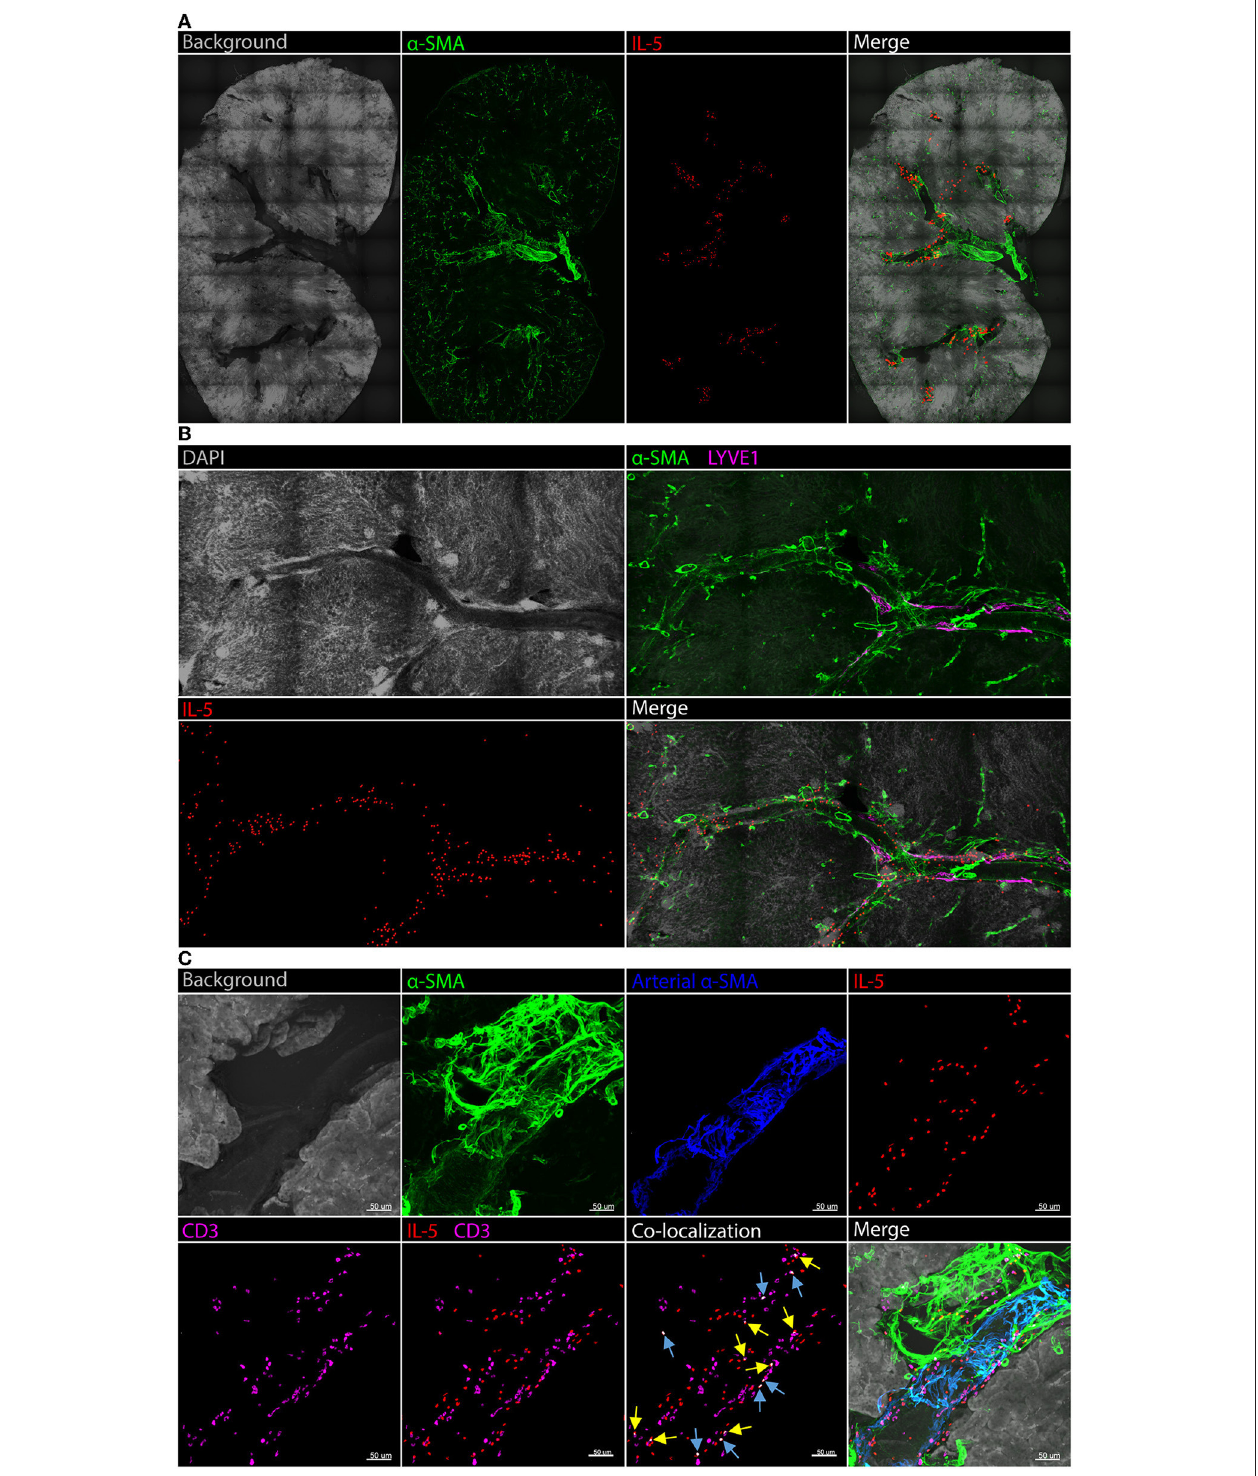
FIGURE 2 | Kidney ILC2s are localized around the vasculature under homeostatic conditions. Kidney sections from Il5 td − tomatoCre ; Rosa-CAG-RFP mice were stained for IL-5 + cells (predominantly ILC2s), the IL-5 + pixel surface area was increased to improve clarity, tissue sections were co-stained for α -SMA for structure determination. (A) Gross structure of the kidney, ILC2s were located in close proximity to the renal vessels throughout the tissue. (B) A magnified view of a vessel